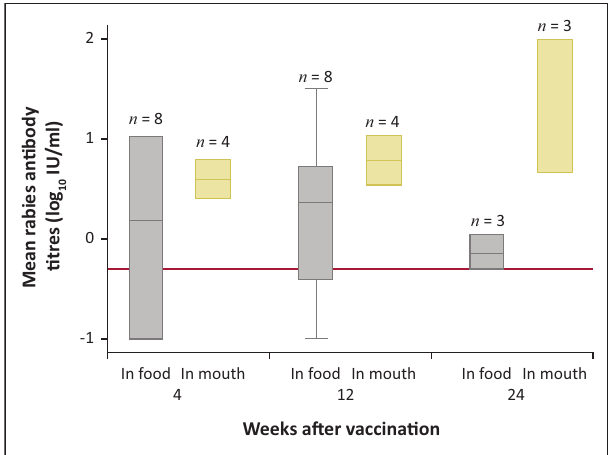
FIGURE 1-A1: Comparison of rabies antibody titres at 4, 12 and 24 weeks after administration of Raboral VR-G  rabies vaccine in food versus orally in captive black-backed jackals. Red reference line = adequate antibody titre (0.5